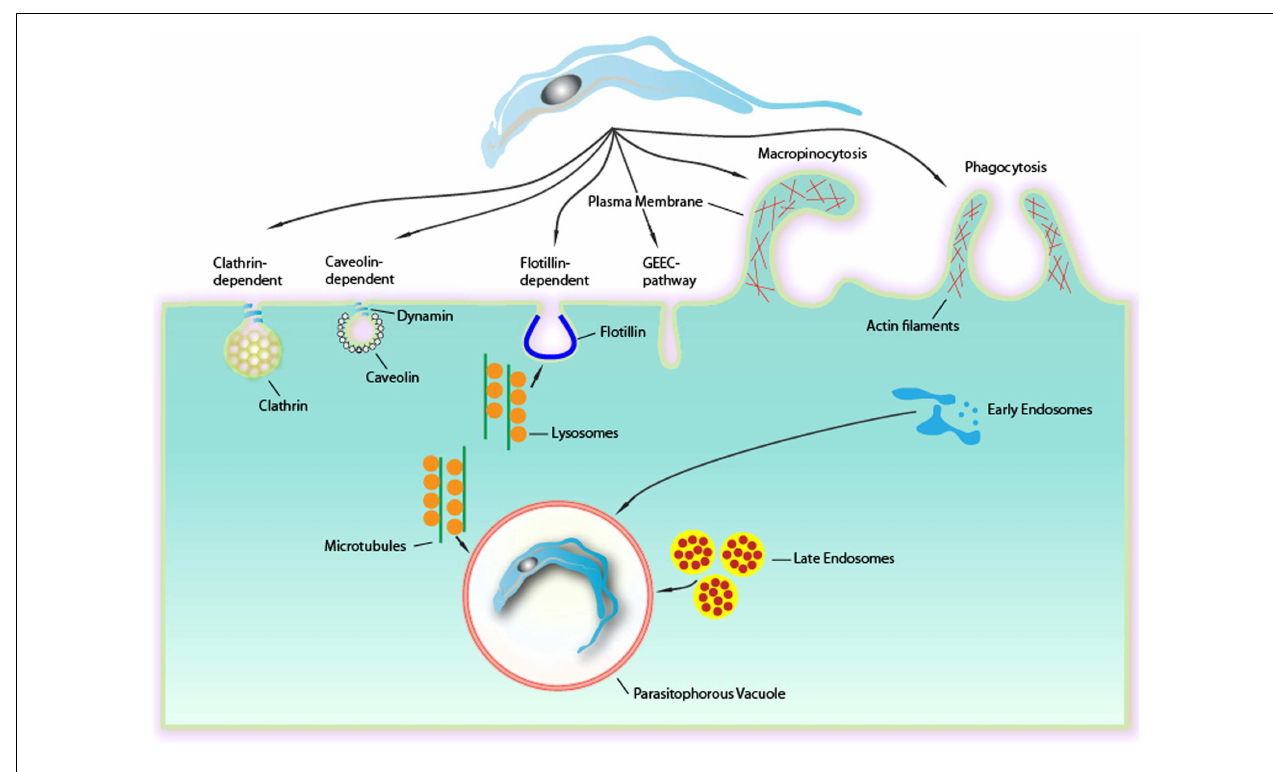
parasite or after entry, with the PV preformed.The fusion of lysosomes in areas of entry-dependent flotillin was recently demonstrated, but it is believed that this can occur in other ways.The targeting of lysosomes to entrance region or the PV occurs via microtubules. Upon entry there is also the fusion of endocytic vesicles (endosomes and late initials) that together with the fusion of lysosomes leads to the maturation of the PV through their acidification.This allowed the destruction of this maturing vacuole of the parasite to escape